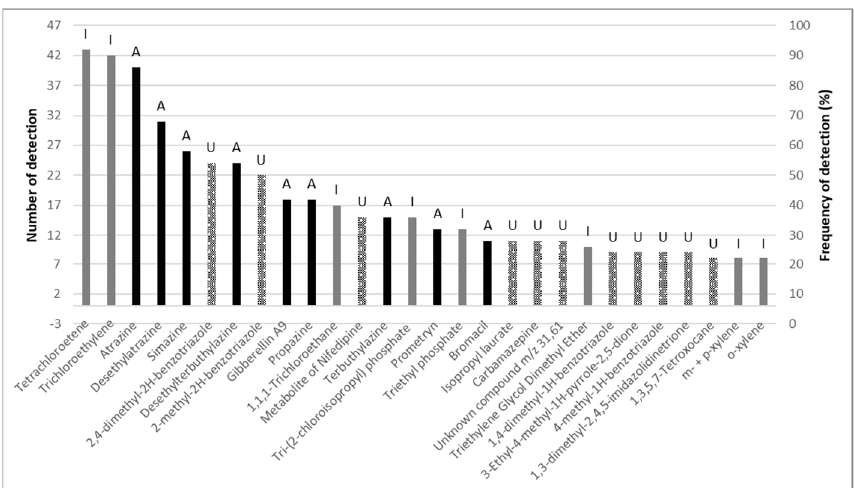
Figure 6. Frequency of selected organic compounds in groundwater based on the type of source (I-industrial, A-agricultural, and U-urban). Table 4. List of selected organic compounds in groundwater, sources, and typical use.